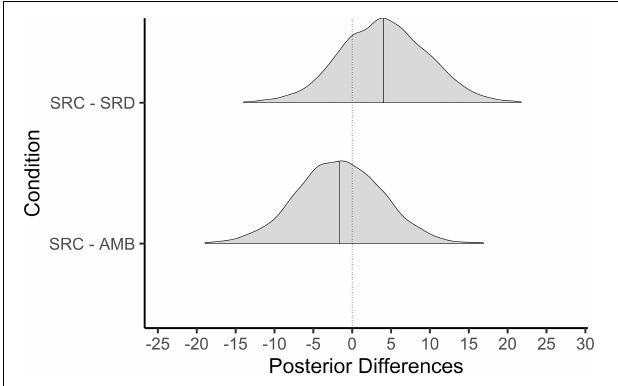
FIGURE 5 | Posterior differences in PEP (‘Fight or Flight’) by condition. Solid line represents the 50th percentile and the dotted line is 0 = no difference.